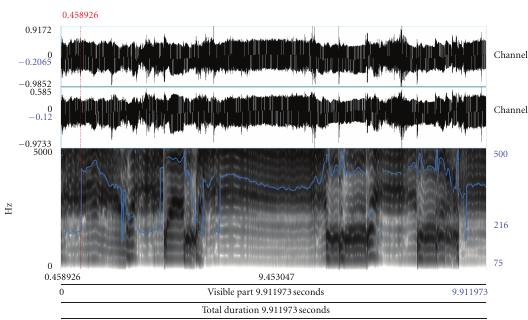
Figure 1: Time domain representation of a cry